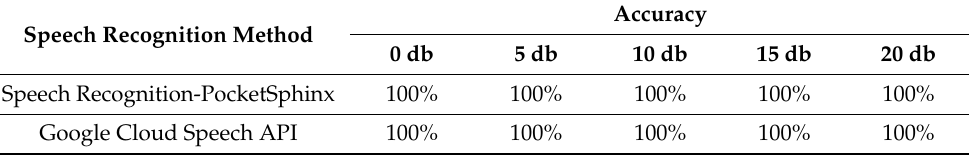
Table 10. The speech recognition